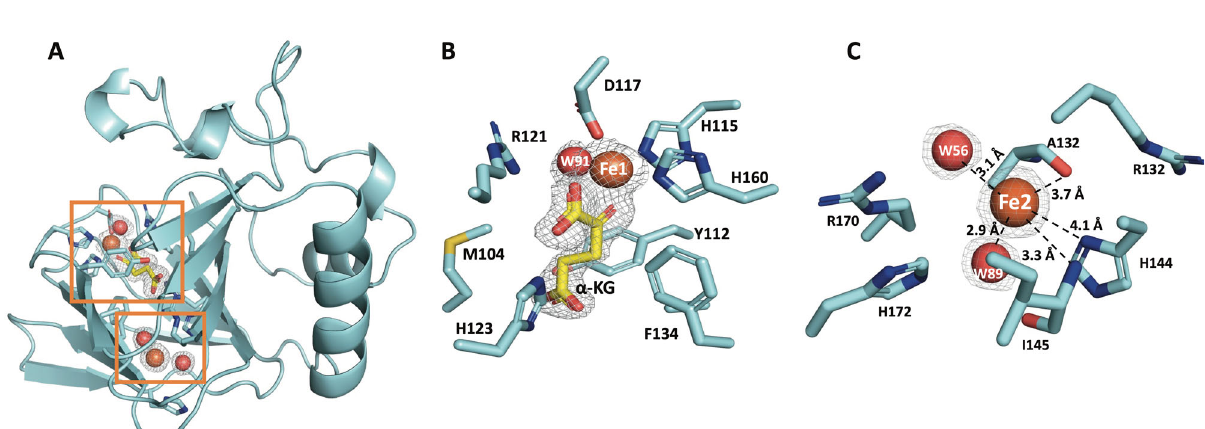
Fig. 4 Crystal structure of Cpz10 in complex with irons and α -KG. A The overall structure of Cpz10, of which the polypeptide chain (colored cyan) folds into a major distorted jelly roll β -sheet core and an α -helical-loop domain. Two irons and α -KG are positioned in the center of the β -sheet core. B The closed-up view of active site, where the active site iron (Fe1, colored orange) is held by a typical facial triad H115, H160, and D117 (cyan sticks) in association with the α -KG bidentate (yellow stick) and a water molecule (W91, colored red) to form a tetragonal bipyramidal coordination geometry. C The closed-up view of the second iron (Fe2, colored orange) which is located in the end of the β -sheet core. Fe2 is associated intimately with two water molecules (W89 and W56 in 2.9 and 3.1 Å, respectively) as well as with the backbone of R133 and in short distance with residues F134, H144, R170, and